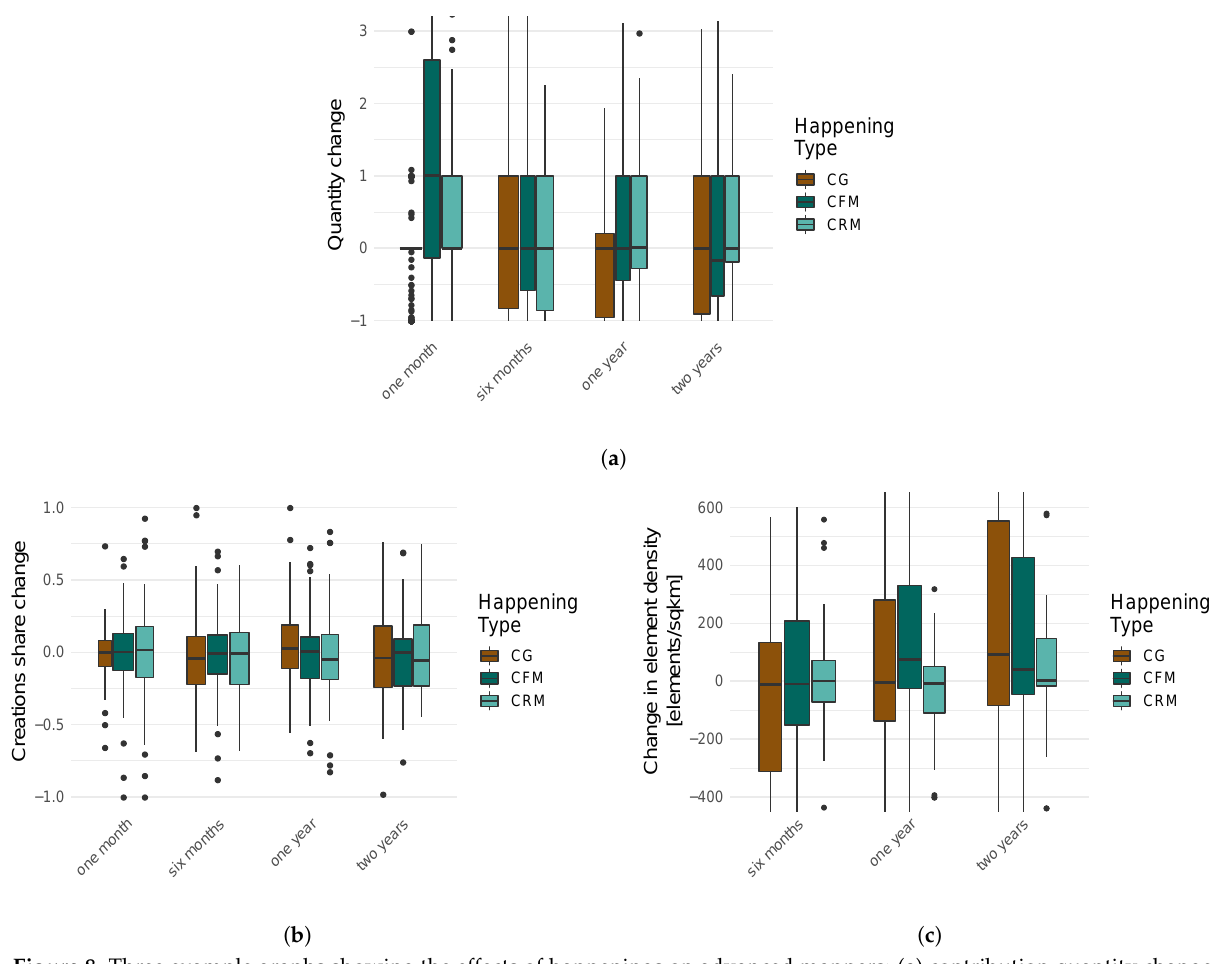
Figure 8. Three example graphs showing the effects of happenings on advanced mappers: ( a ) contribution quantity change, ( b ) creations share change and ( c ) element density change. In contrast to the analysis of newcomers, differences in values before and after the event for matching time intervals are shown here. The quantity produced by happening attendees increased for one month while a large part of the CG decreased their quantity in all time intervals. While the share of creations did not change through an event, the element density mostly increased for all groups over time. The width of the boxes is relative to the number of mappers in the respective class (see Table 3). Graph ( a ) was cropped at 3, but the total maximum was 22,191. Graph ( c ) was cropped between –400 and 600, but the total range was − 12,885.92 to